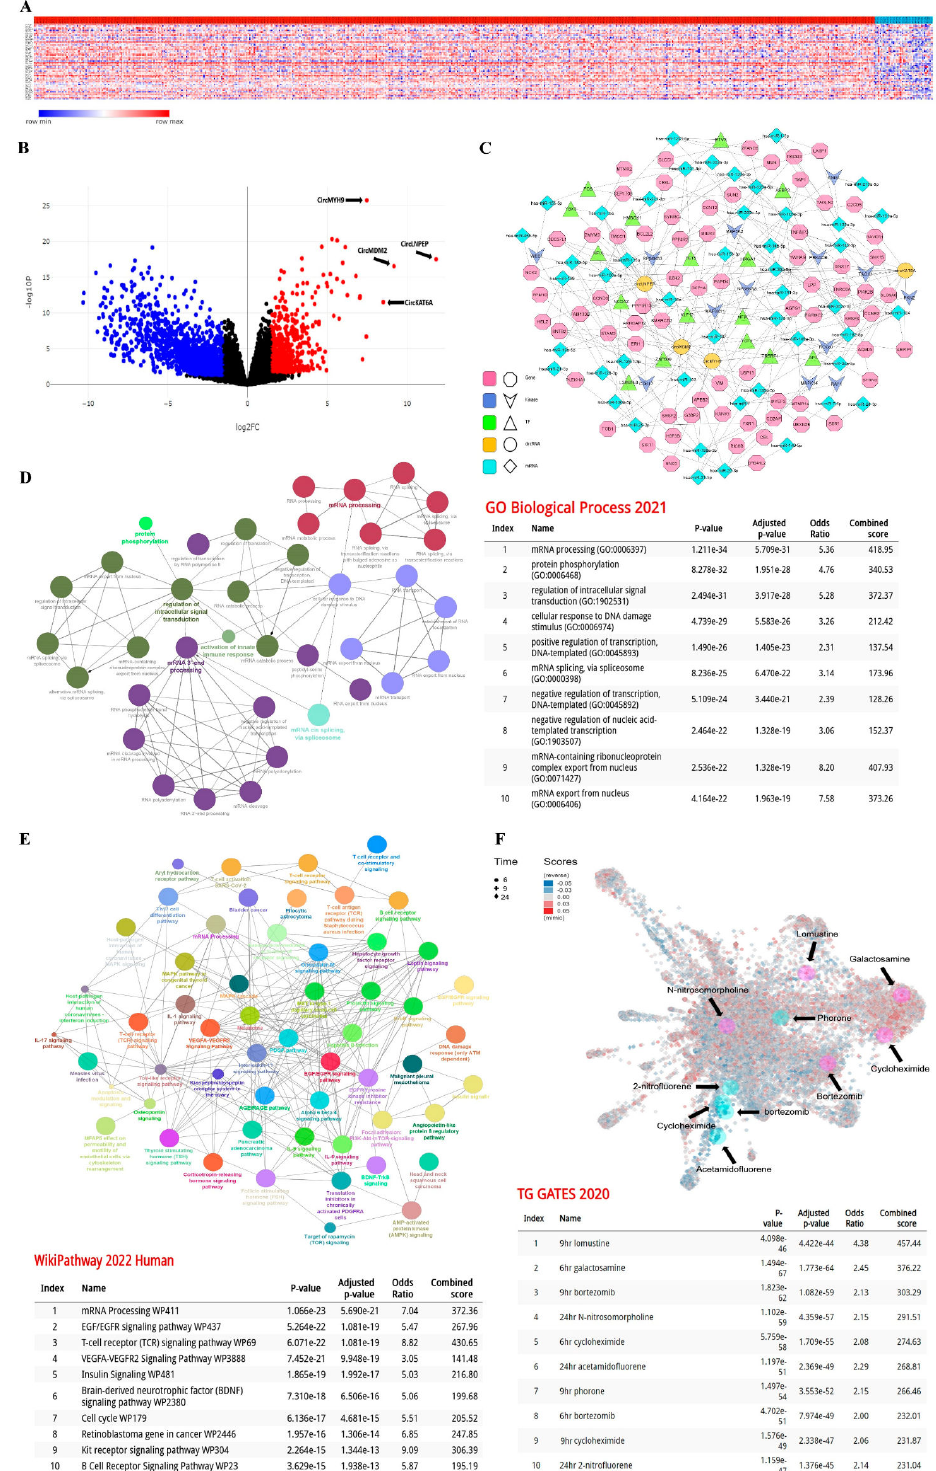
Figure 1. Bioinformatics analysis of circRNAs in CLL samples. ( A ) Heatmap demonstration of 52 differentially expressed circRNAs between CLL lymphocytes (red bar, right) and normal B-cells (blue bar, left). ( B ) Volcano plotting of deregulated circRNAs in CLL samples. ( C ) Interaction analysis between candidate circRNAs and other signaling mediators. ( D ) Gene ontology (GO) biological process and ( E ) WikiPathways enrichment analysis of gene networks. ( F ) Drug sensitivity prediction of gene networks in